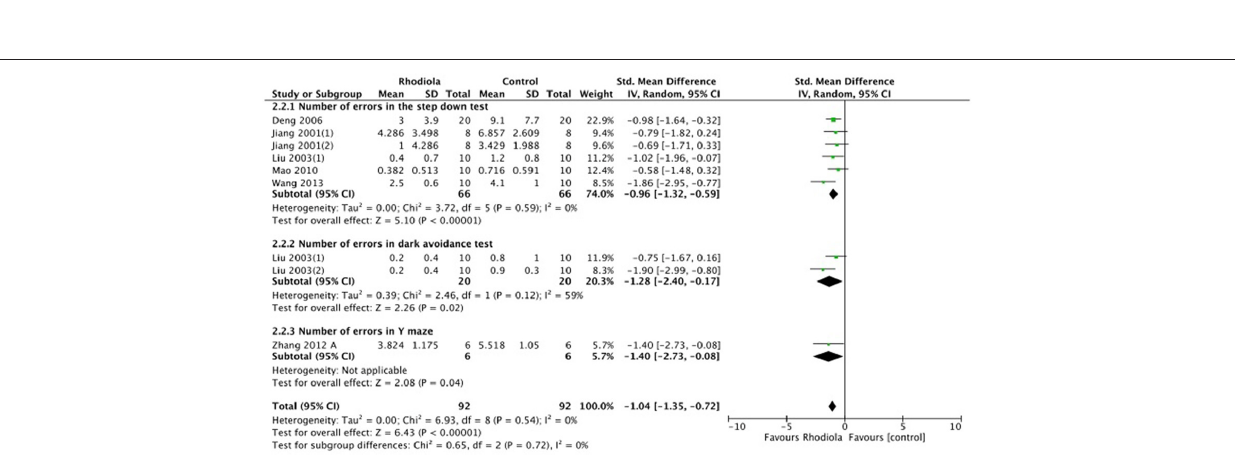
Frontiers in Pharmacology |